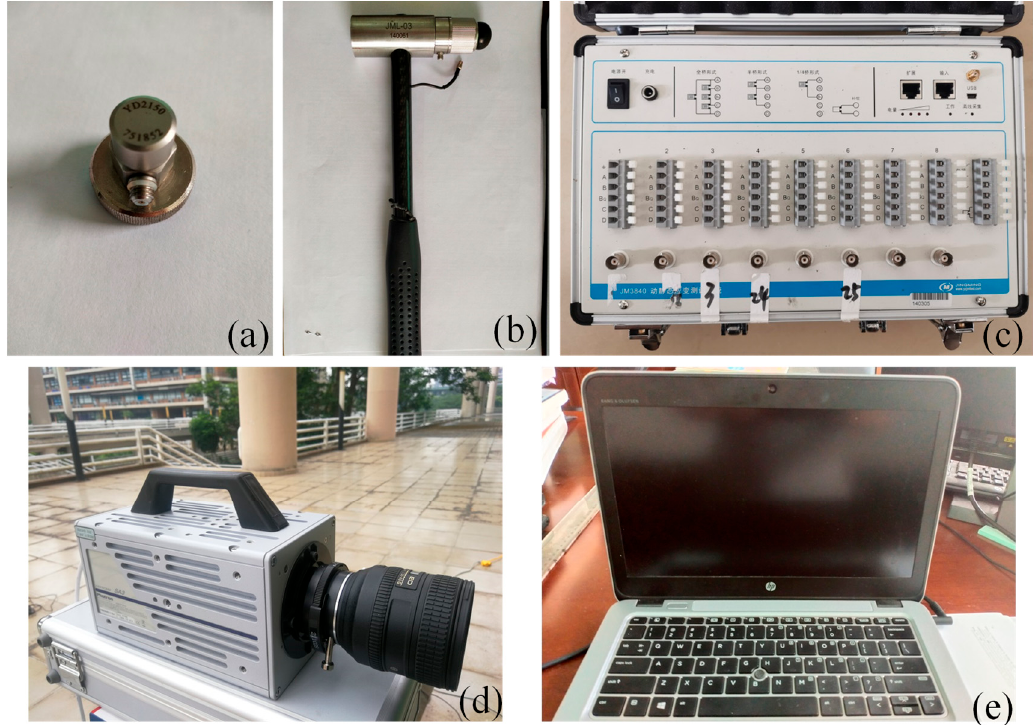
Figure 2. Experimental facilities. ( a ) accelerometers; ( b ) hammer; ( c ) JM3840 dynamic data acquisition instrument; ( d ) FASTCAM SA3 high-speed camera; ( e ) laptop.